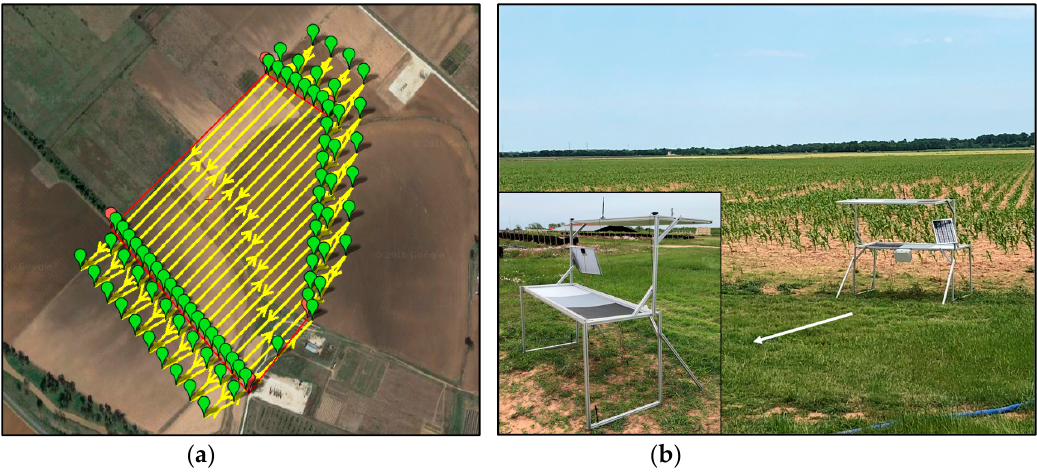
Figure 6. View of ( a ) the planned flight path pattern generated for the UAV and ( b ) the validation test in the field.